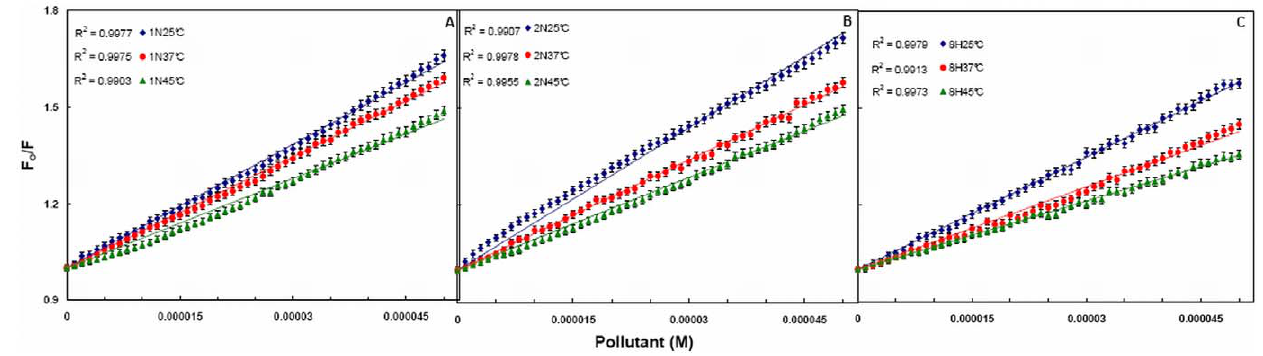
Figure 4. Stern-Volmer plot between Fo/F and [Pollutants] for HSA–pollutant interaction. (A) for HSA–1N, (B) for HSA–2N and (C) for HSA– 8H at 25, 37 and 45 u C. [HSA=2 m M; 1N=2N=8H=0–50 m M].